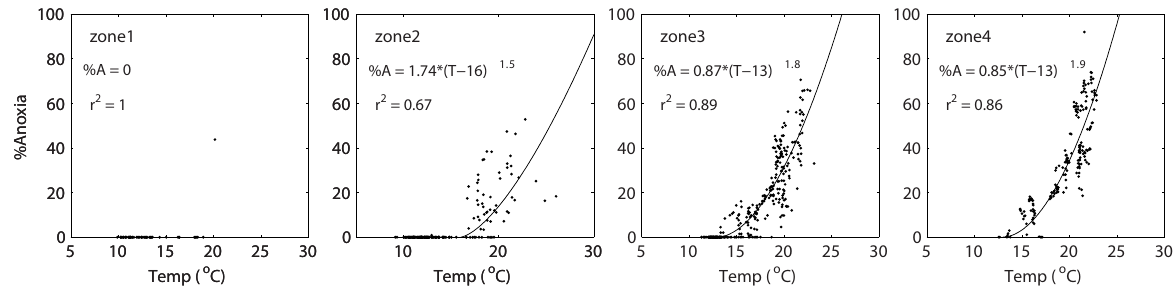
Fig. 11. % Anoxia (%A) as a function of bottom water temperature ( T ) for the four zones in the Yarra River